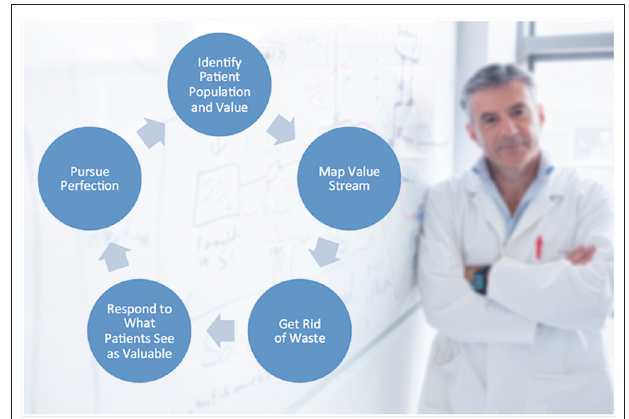
FIGURE 2 | Flow chart showing an example of Lean Six Sigma (LSS) methods applied to medical practice. Image source: https://www.ausmed.com/articles/